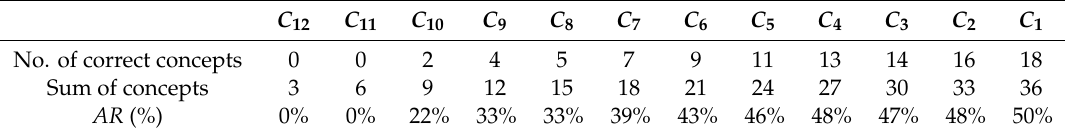
Table 6. Learning achievement results for student 5, who correctly answered Q 1 , Q 2 , Q 5 , Q 6 , Q 9 – Q 11